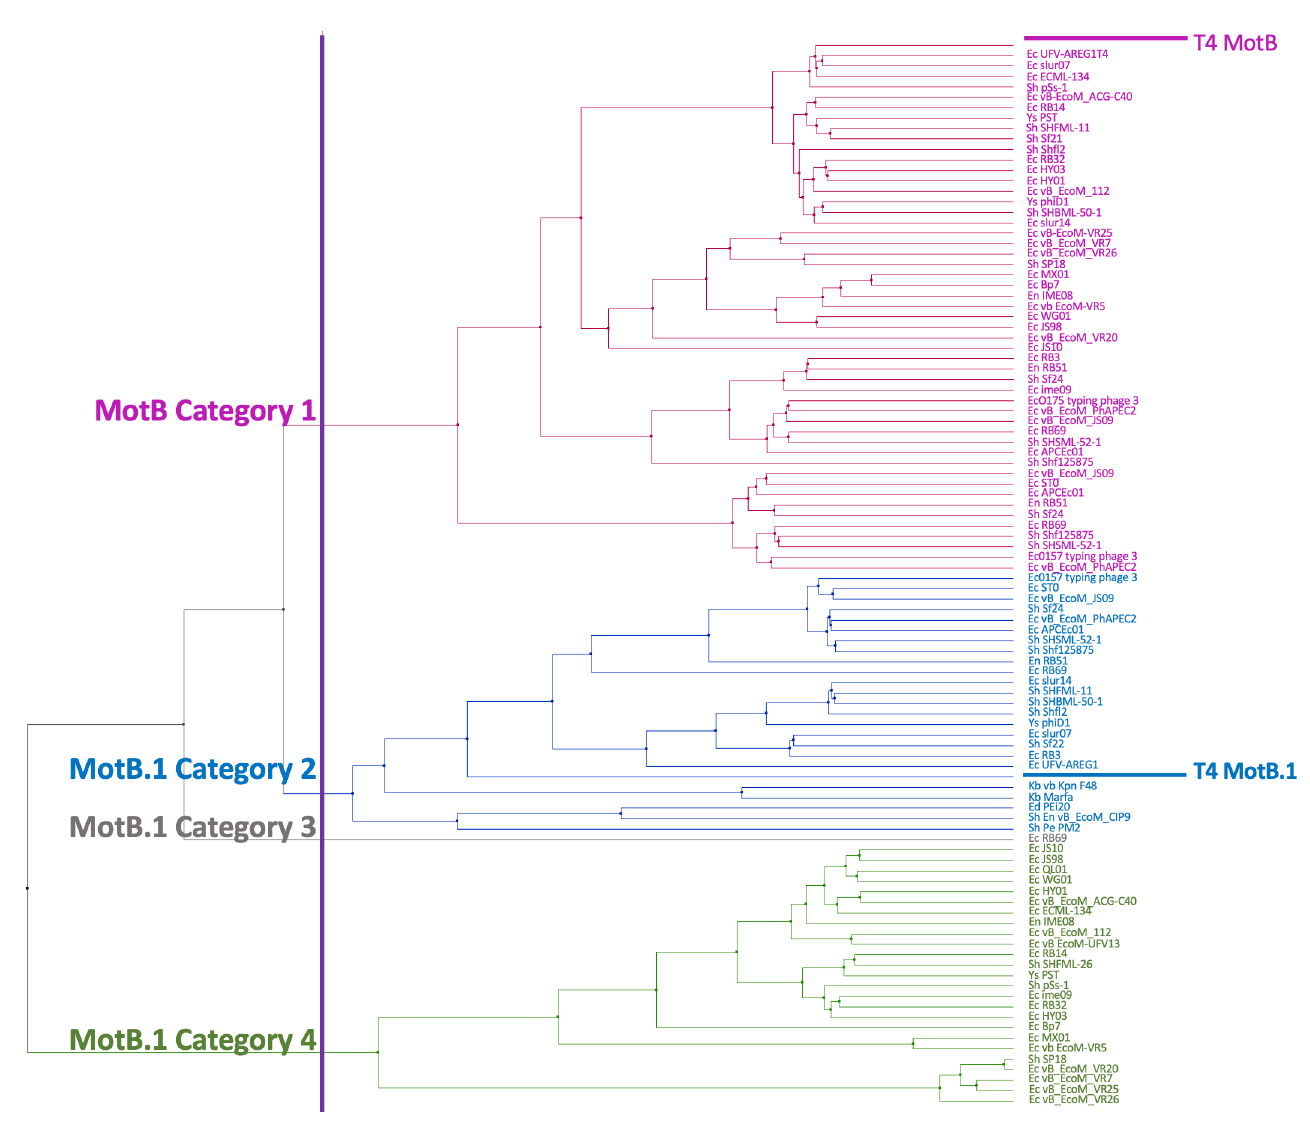
Figure 2. MotB phylogenetic tree. A multiple sequence alignment generated by COBALT for the 102 PSI-BLAST phage hits was used to construct the UPGMA tree. The purple vertical line indicates where cutting of the tree generates 4 branches, separating MotB homologs (Category 1, magenta) from the related MotB.1 homologs (Category 2, blue; Category 3, grey; Category 4, green). Names on the right indicate the host (Ec: Escherichia , Sh: Shigella , En: Enterobacter , Ys: Yersinia , Ed: Edwardsiella , Kb: Klebsiella ) followed by the phage name. See Table S4 for details about each protein; order here is same as order in Table